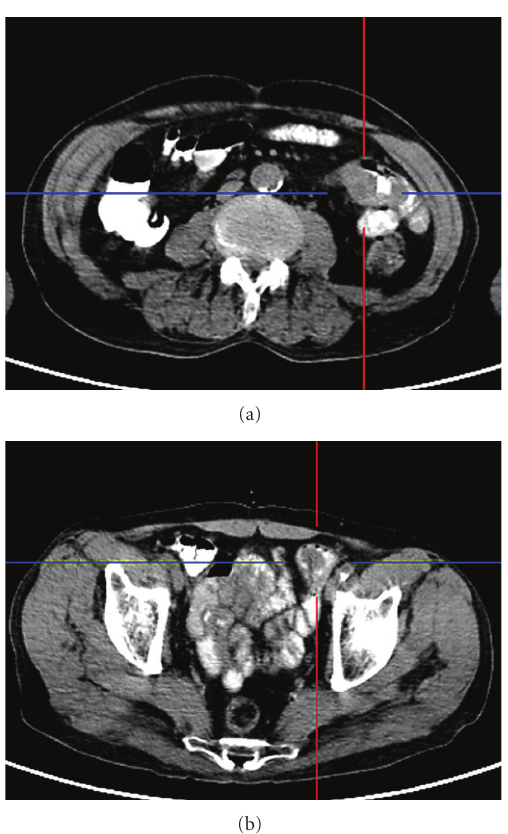
Figure 1: Abdominal CT image of tumors located in the small intestines.